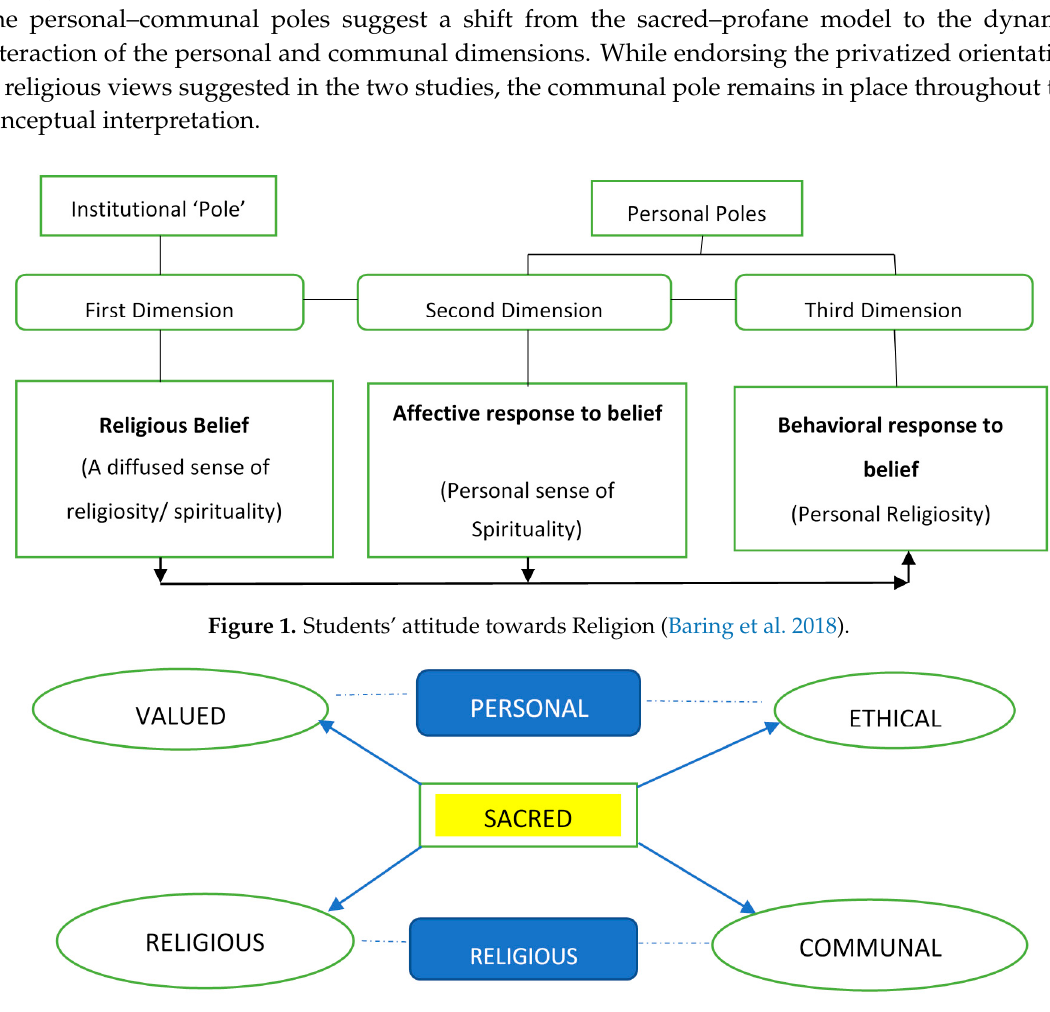
Figure 2. Aspects of the sacred (Baring et al. 2017).